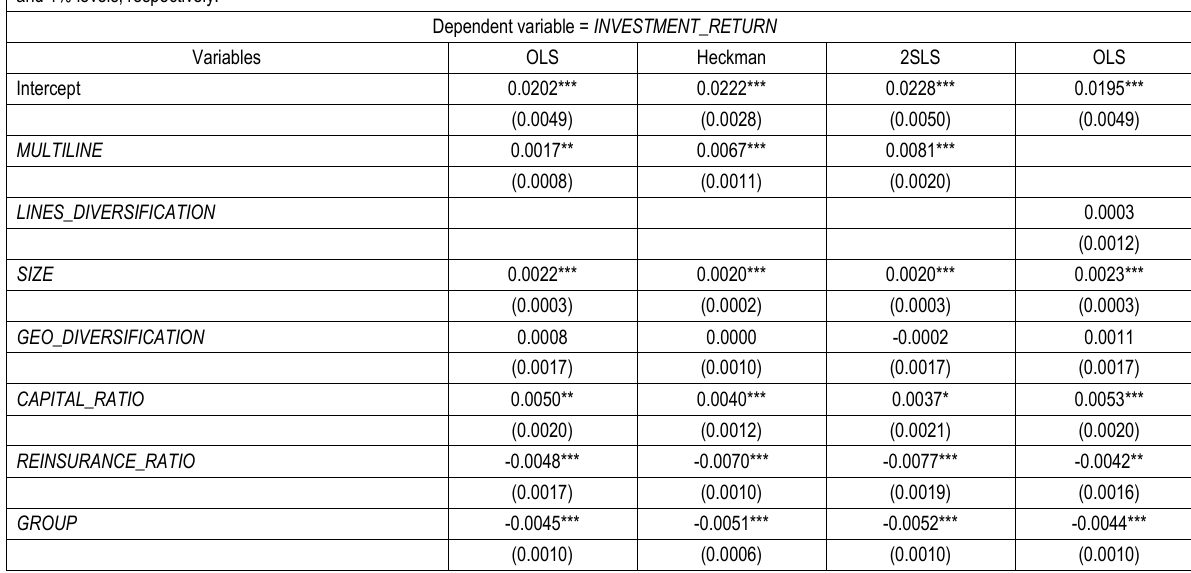
Table 3. Diversification effect on investment